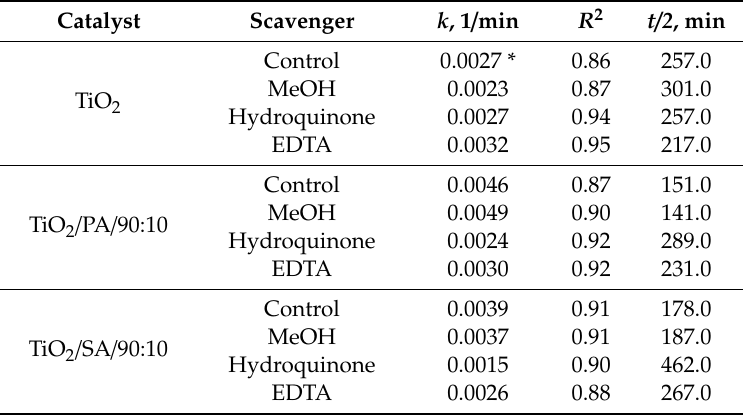
Table 7. E ff ect of radical scavengers on photodegradation kinetics.